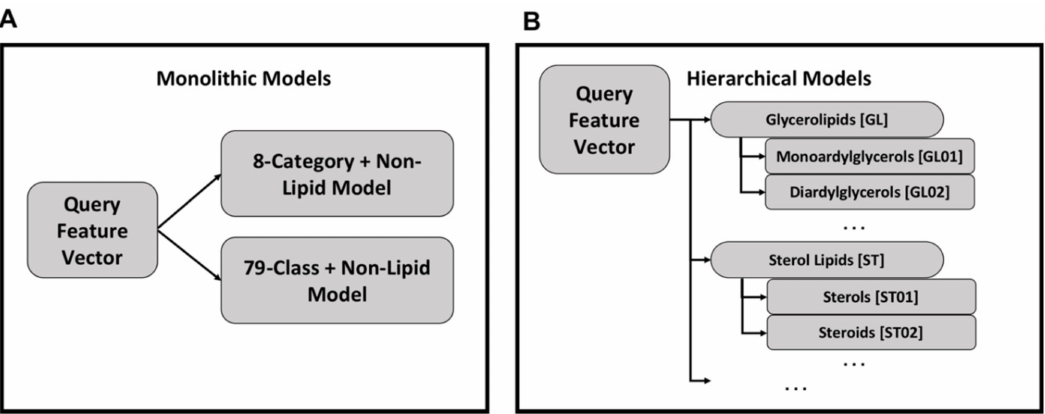
Figure 3. Organization of monolithic and hierarchical models—in a monolithic organization there exists one model for classifying feature vectors into lipid categories and another model for lipid classes (Panel A ). This organization is simpler with fewer models to train compared to the hierarchical organization of models (Panel B ). In the hierarchical organization, there is one model per category and class, with the class models organized under their respective category